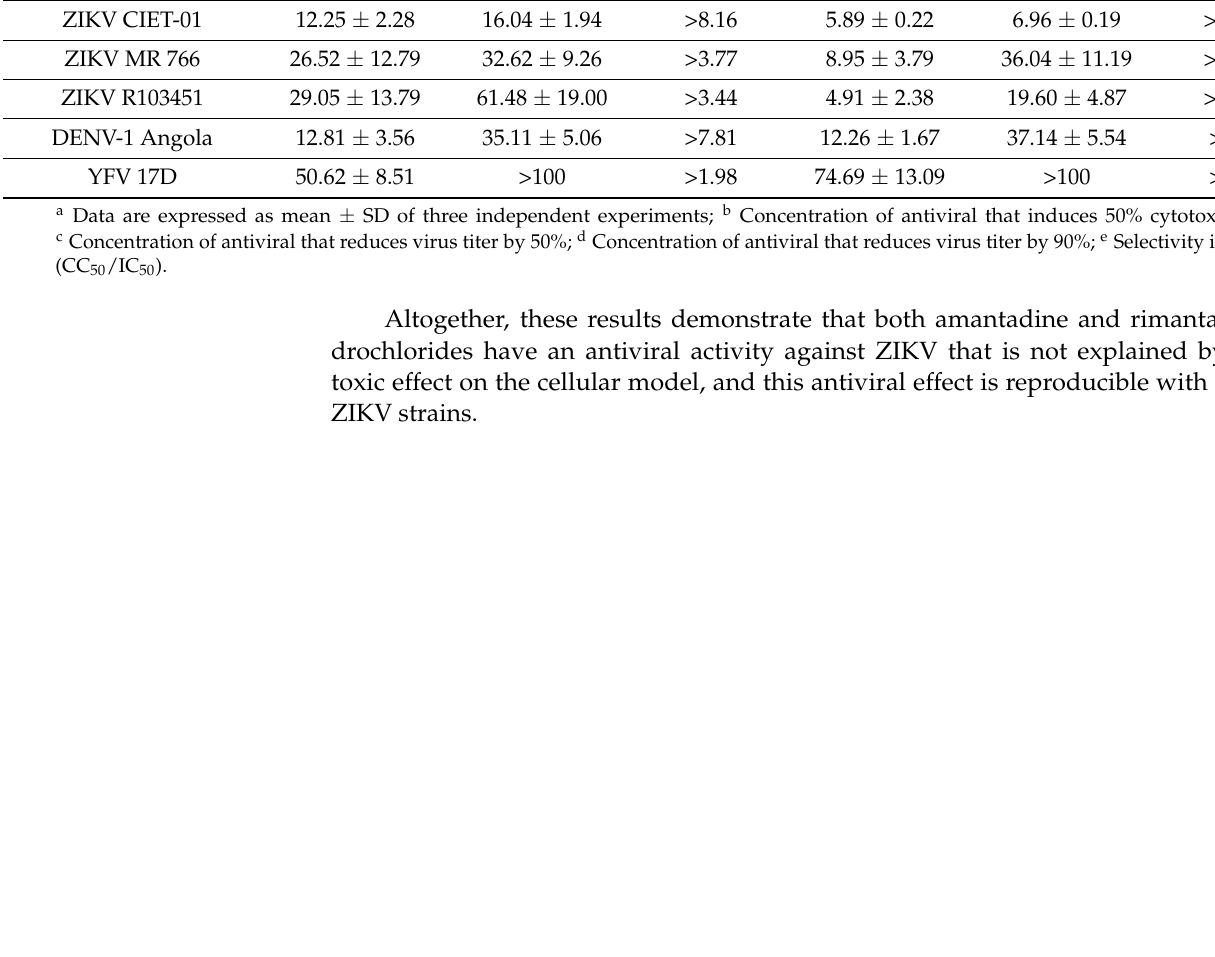
Table 1. Antiviral activity of amantadine and rimantadine hydrochlorides against ZIKV, DENV, and YFV in vitro a .